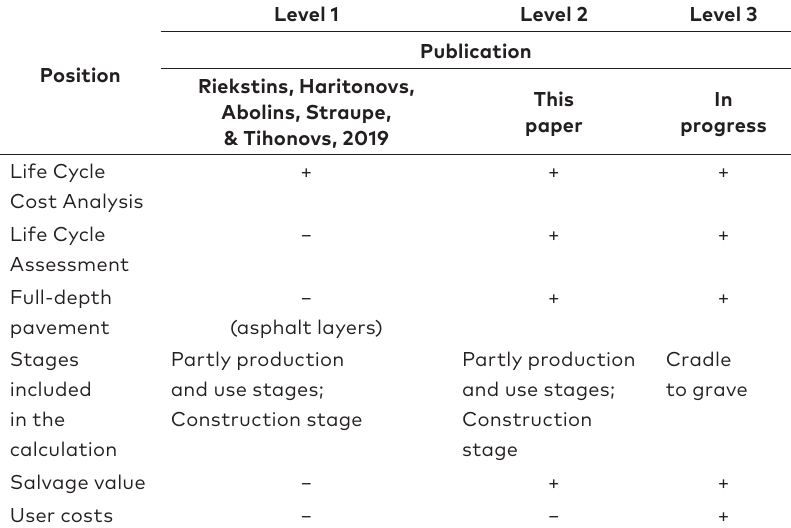
Table 1. Summary of calculation development